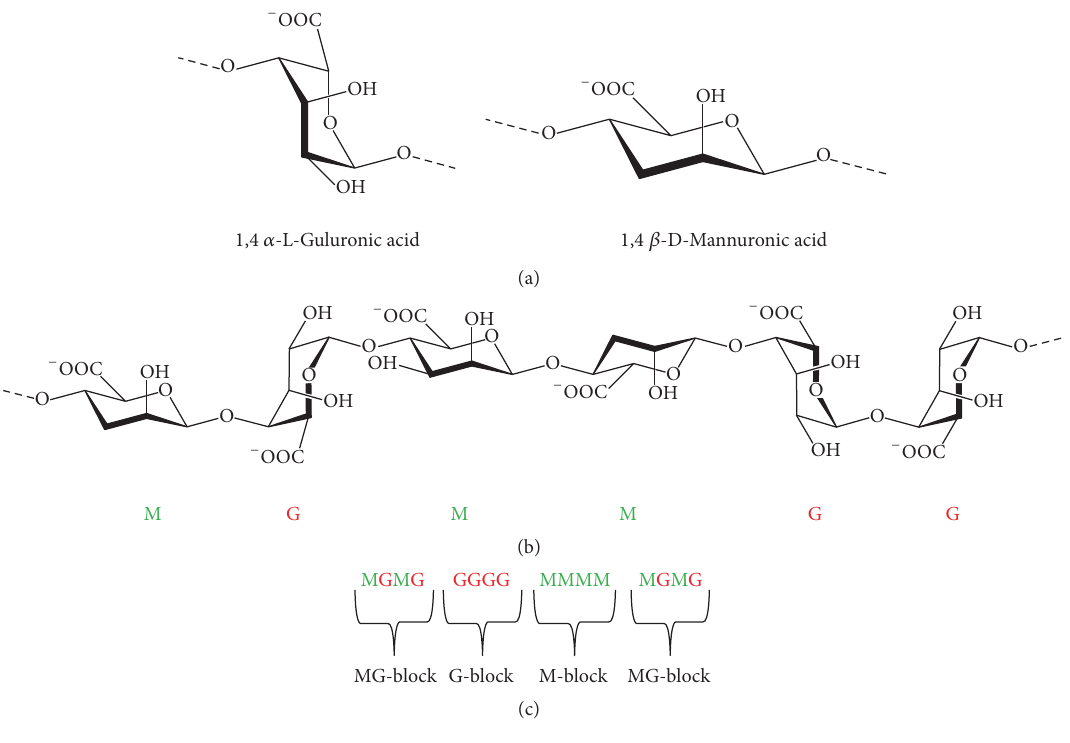
Figure 1: The structure of ALG: monomers (a), chain conformation (b), and blocks distribution (c).